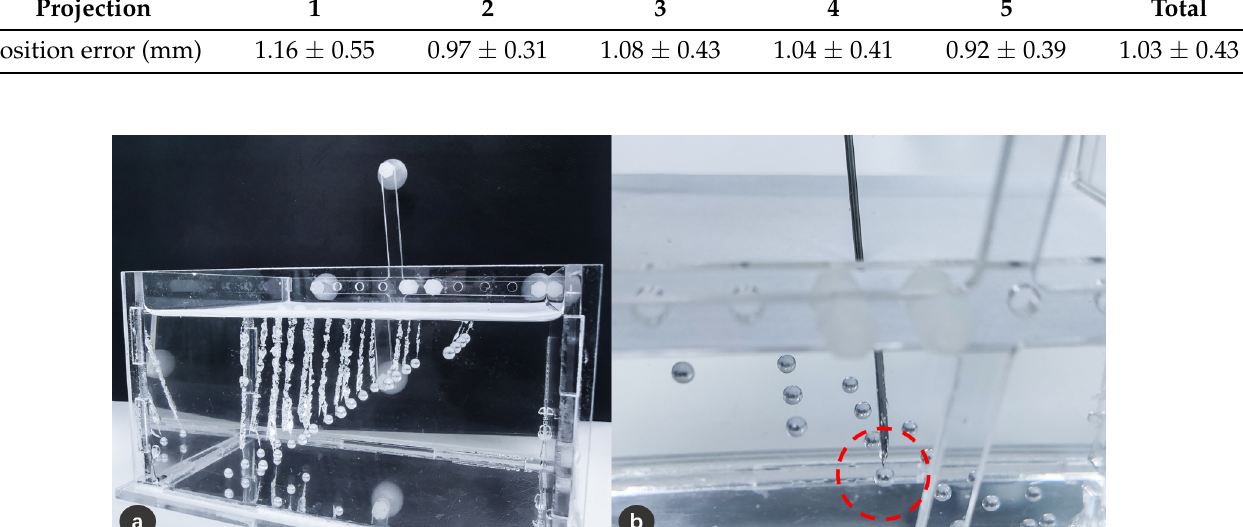
Figure 13. Schematic diagram of puncture experiment results. ( a ) The trajectories formed on the silicone after needle puncture, and these trajectories have successfully reached the lesion; ( b ) It can be clearly confirmed from the side that the needle has reached the